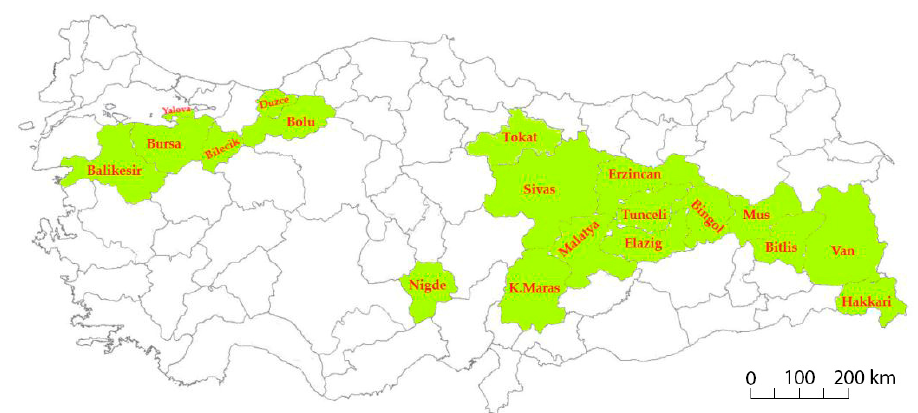
Figure 1. Collection provinces of Turkish common bean germplasm.